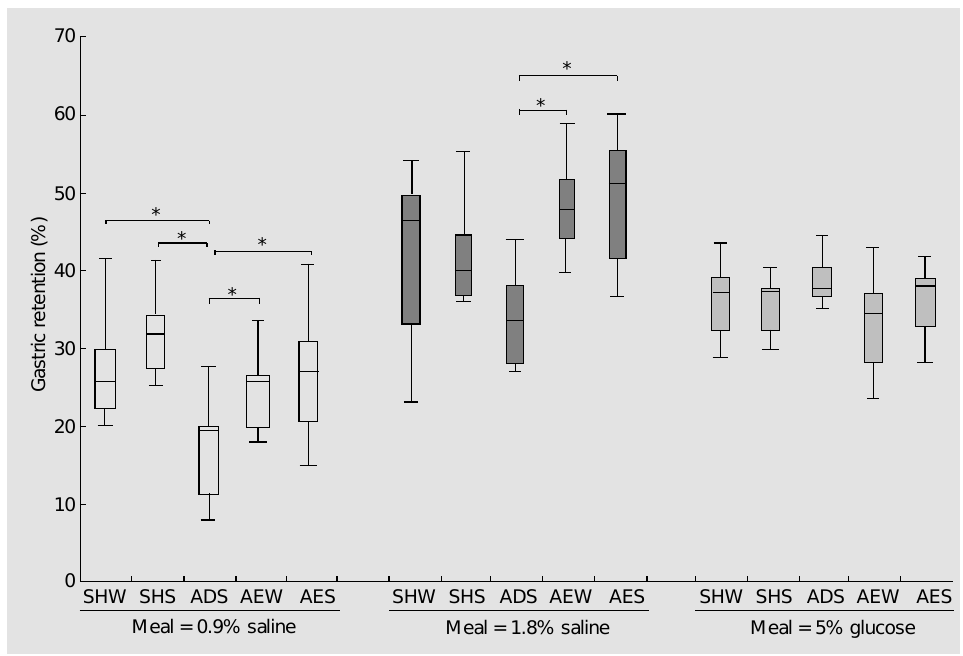
Meal = 1.8% saline Meal = 5% glucose